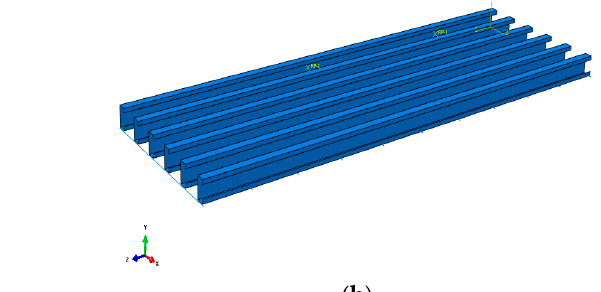
Figure 9. Load-strain relationships of the top surface of the foam concrete and bottom surface of the cold-formed thin-walled C steel channels. ( a ) Top surface of the foam concrete slab; ( b )Top surface of the cold-formed thin-walled C steel channels.